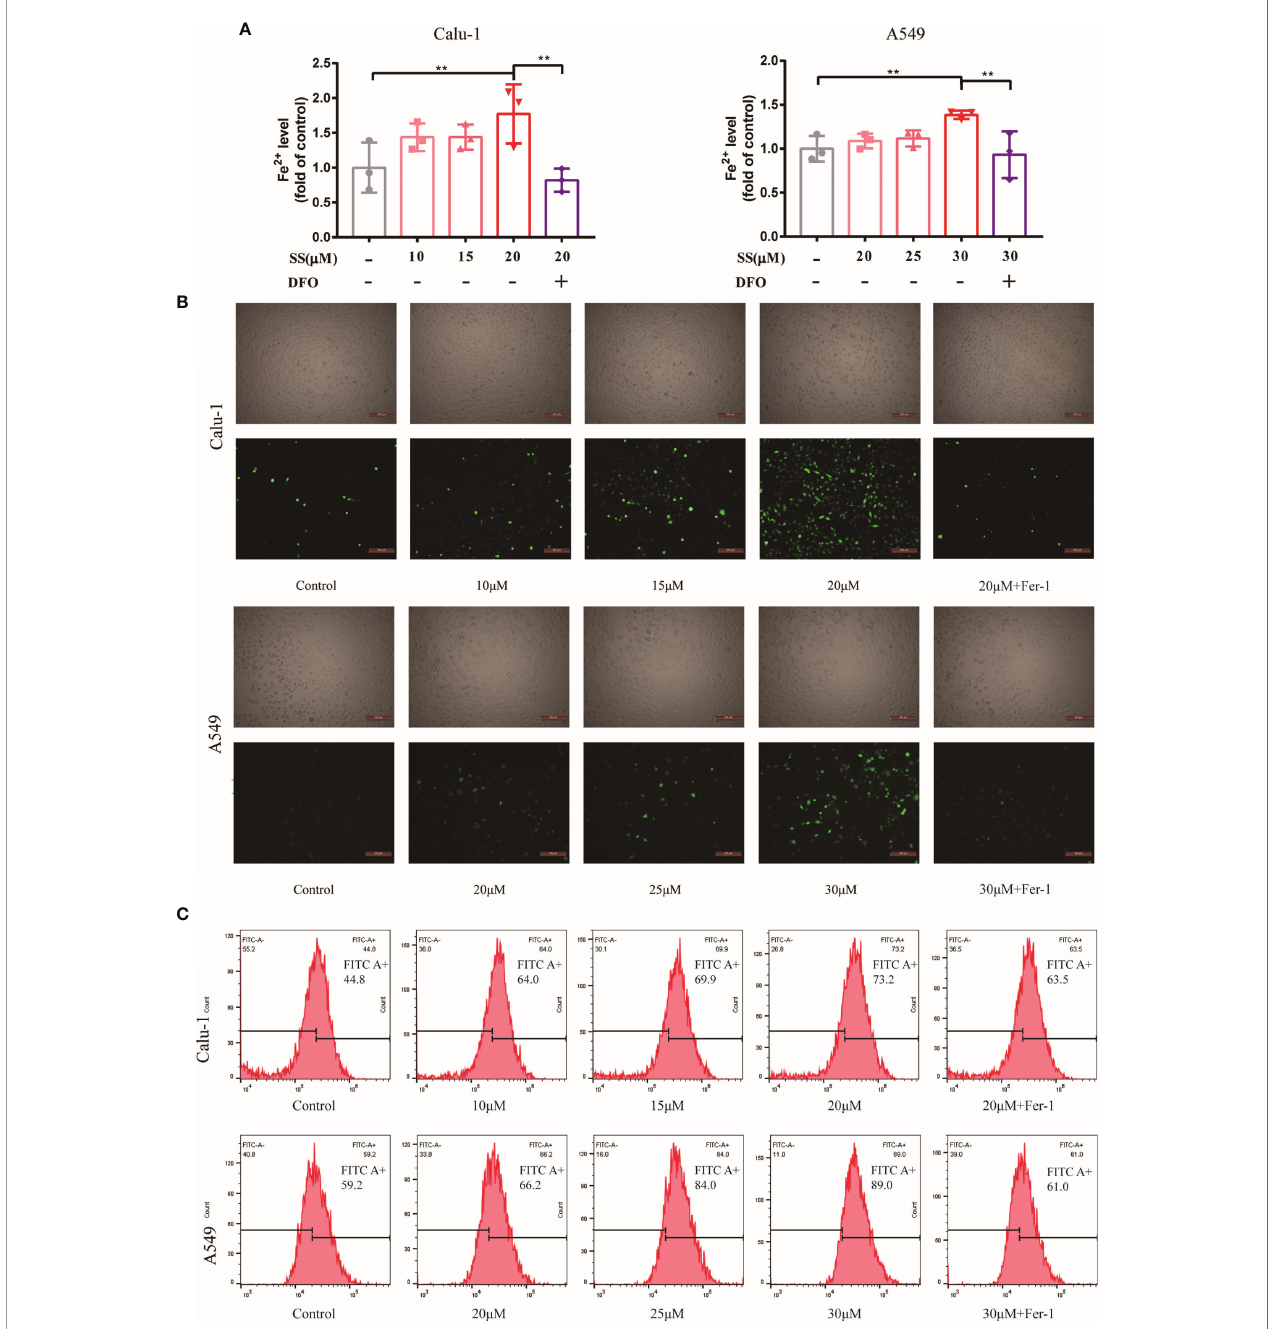
FIGURE 3 | SS caused Fe 2+ overload and ROS accumulation in LUAD cells. (A) Flow cytometry was used to detect the Fe 2+ level in Calu-1 or A549 cells, which were respectively treated with 10, 15, 20 m M or 20, 25, 30 m M of SS for 6 h and pretreated with or without DFO (80 m M), the data statistic was shown in a histogram. (**P < 0.01). (B, C) Fluorescence microscopy and fl ow cytometry were used to detect ROS production in Calu-1 or A549 cells treated for 6 h with 10, 15, 20 m M or 20, 25, 30 m M SS and pretreated with or without Fer-1 (1 m M), scale bars: 200 m